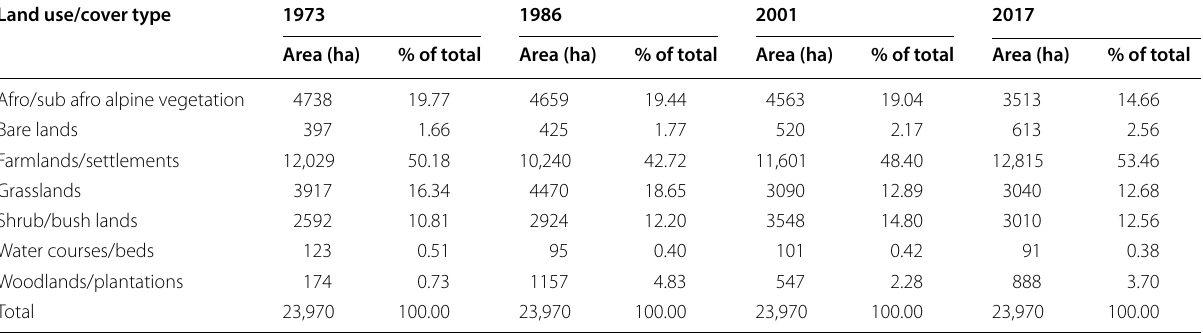
Table 4 Area cover of the land use/cover classes of the watershed at different periods of time. Source: Interpreted from satellite image,